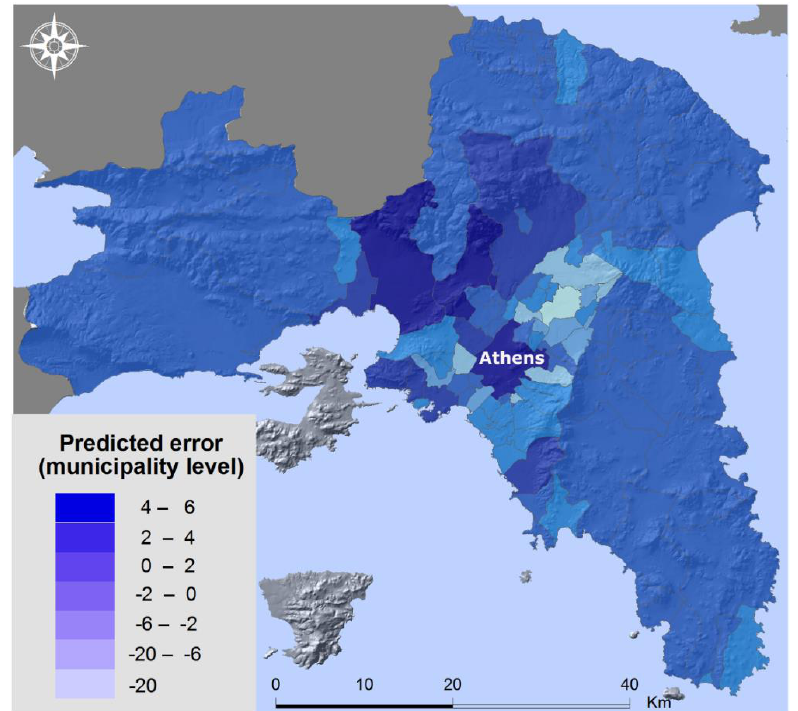
Figure 6. Prediction error (spatial regression model).